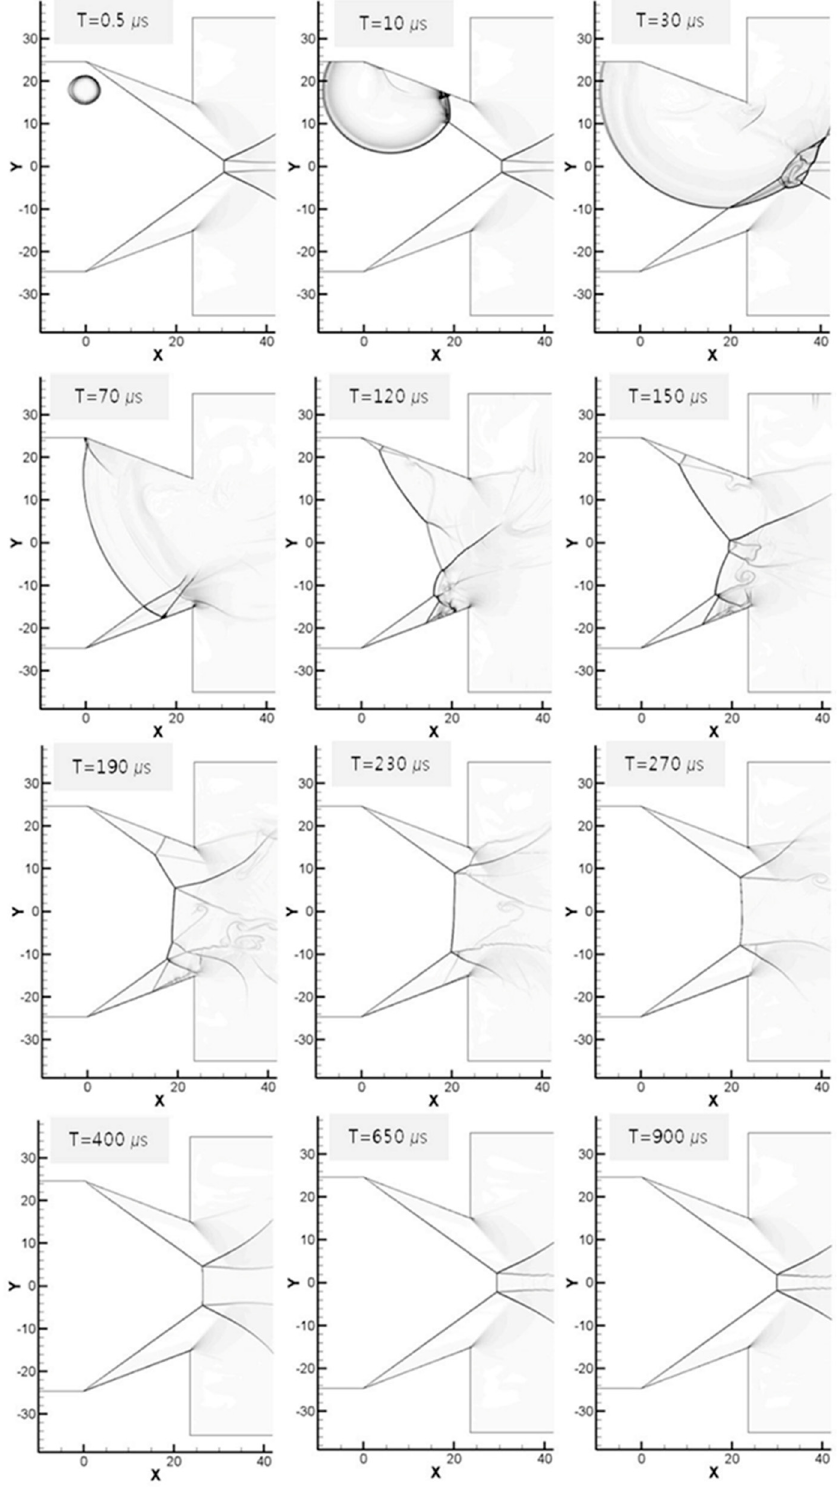
Figure 11. Interaction between blast wave and oblique shock, deposition upstream of the wedges. Energy: 430.0 mJ. Energy: 430.0